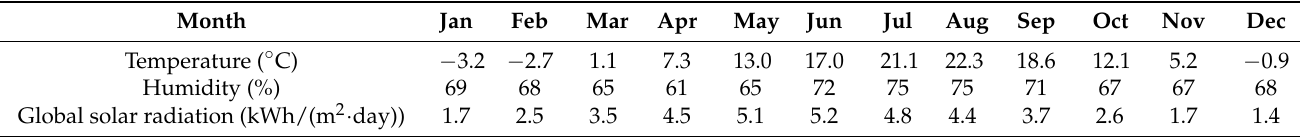
Table 1. Monthly mean of weather conditions in Sapporo from 1991 to